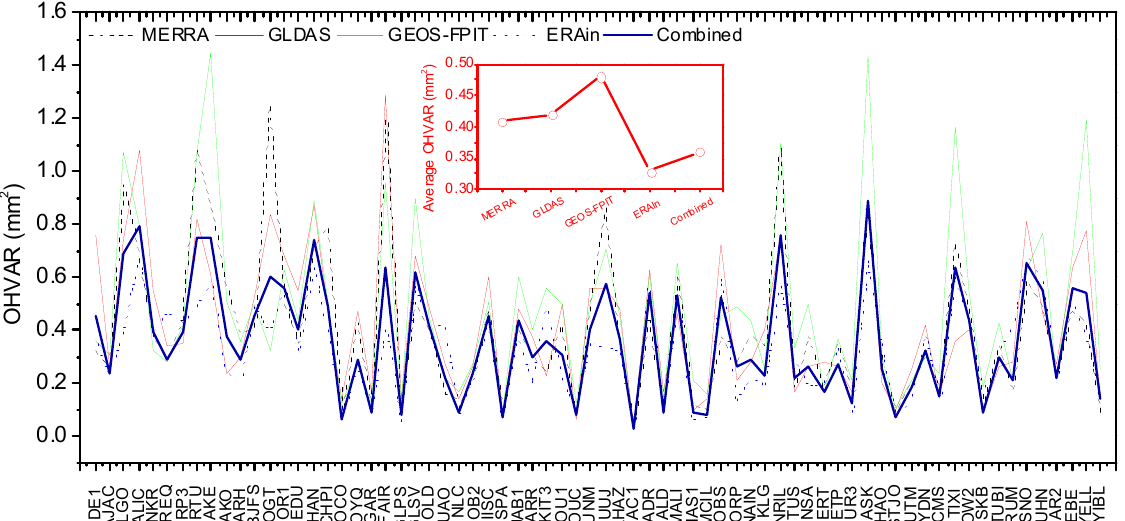
Figure 6. Mean overlapping Hadamard variance (OHVAR) of different hydrology loading predictions and their combinations. The averaged OHVARs of 70 GPS sites were provided and inserted in the figure.